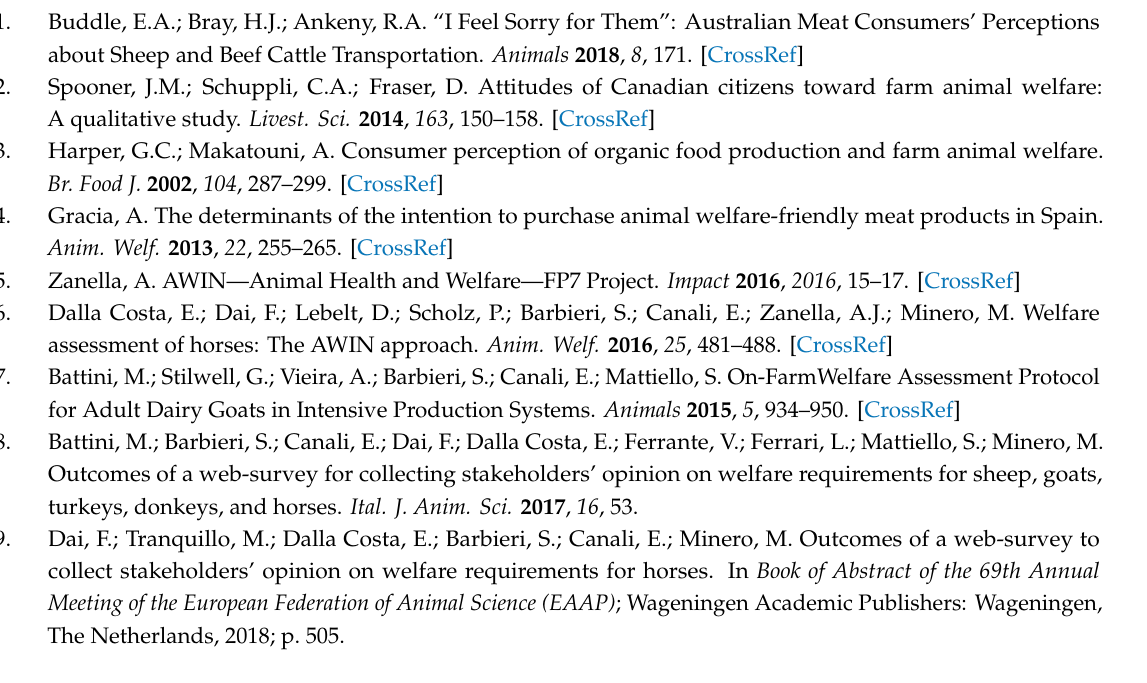
Table S1: List of the questions reported in the